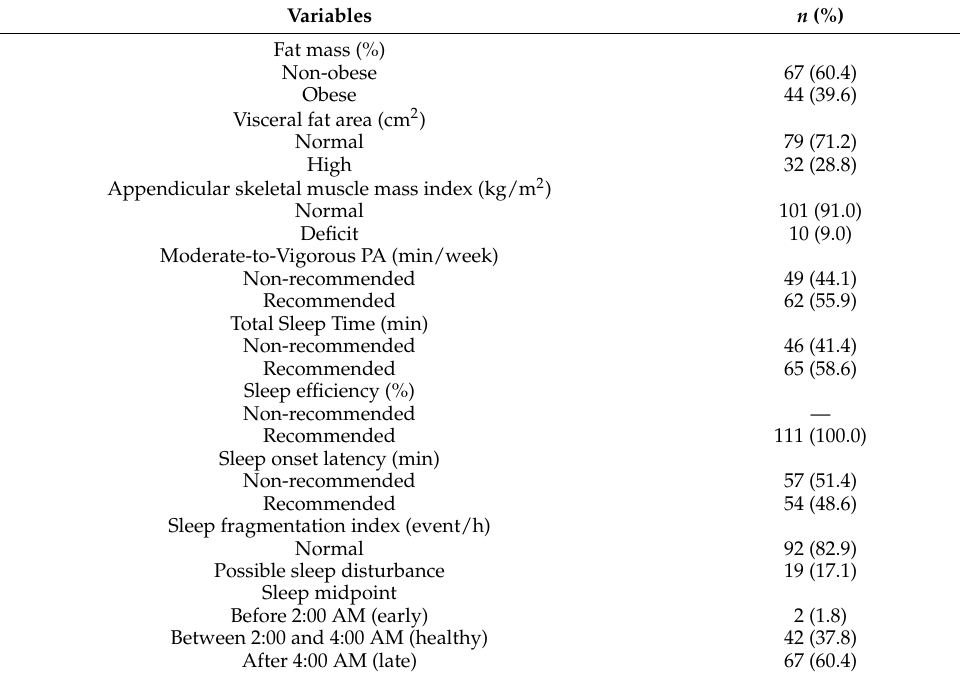
Table 2. Classification of adiposity, physical activity levels, and sleep ( n =